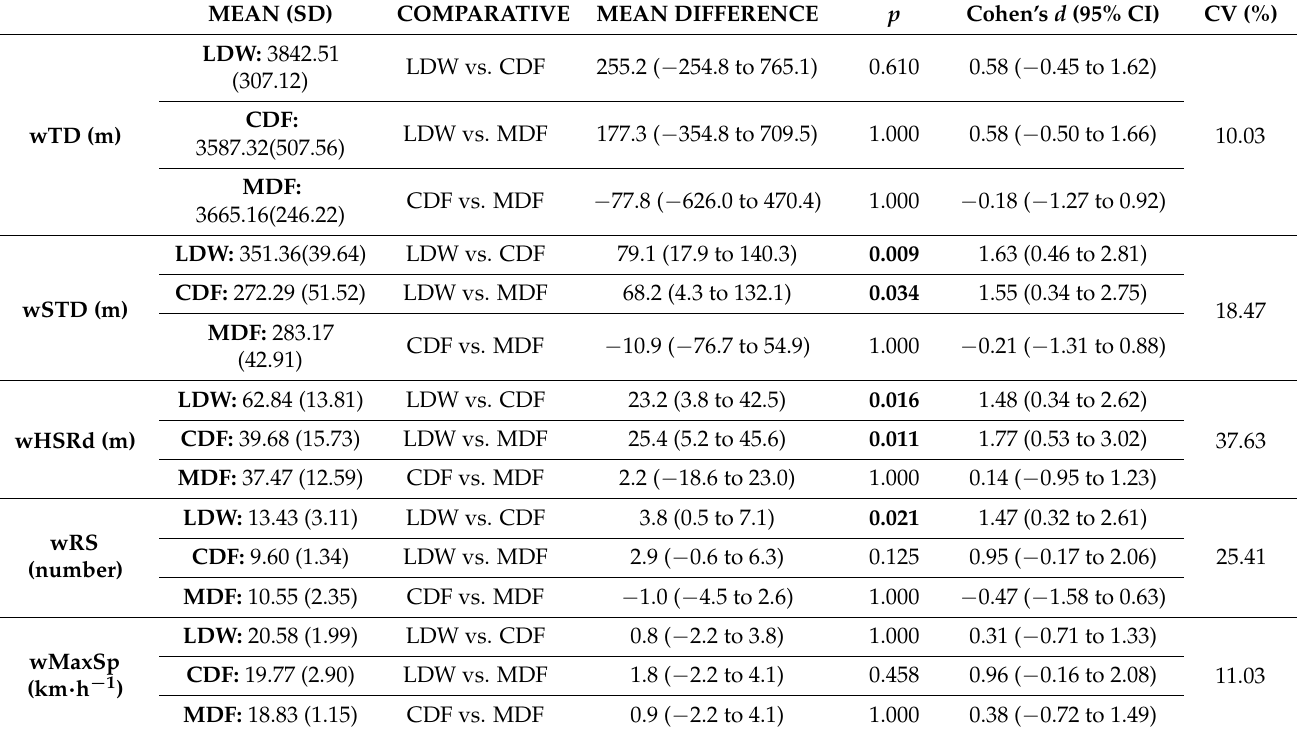
Table 3. Between-group differences for derived-GPS variables of distance and sprint in the full